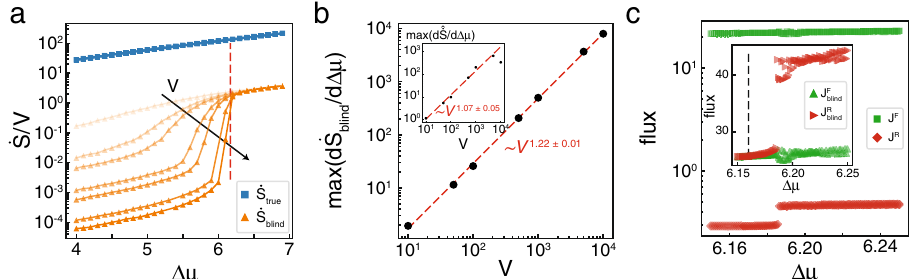
Fig. 3 Finite size scaling of _ S . a _ S true = V (blue squares) and _ S blind = V (orange triangles) for system volumes V = [10, 50, 100, 500, 1000, 5000, 10000], showing an increasingly sharp transition in _ S blind , but not in _ S true . _ S blind shows no volume dependence below the transition, and is linear dependent on V above it. Vertical red dashed line shows Δ μ HB . b Maximum value of ∂ _ S blind = ∂ Δ μ shows a power-law dependence with volume. Inset shows the same measurement ^_ S = ∂ Δ μ for ∂ . c Forward and reverse fl uxes, J F (green squares) and J R (red diamonds), obtained from numerical integration of deterministic equations of motion for the Brusselator. Inset shows J F (green upright triangles) and J R (red rightward triangles). Vertical black dashed line shows Δ μ blind blind